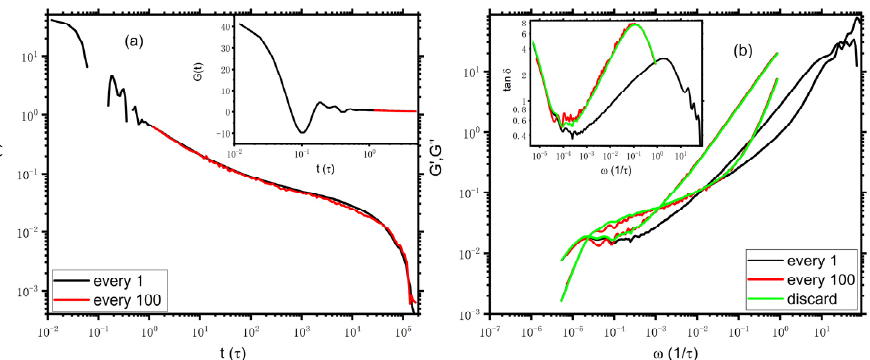
Figure 3. Stress relaxation ( a ) and viscoelastic moduli ( b ) of 𝑁 = 129 . The absolute values of 𝐺(𝑡) are input into i-Rheo GT, and the value of 𝐺(0) is 43.7. The inset in panel ( b ) presents the loss tangent tan𝛿 vs. frequency. The legends of “every 1” and “every 100” indicate the stress is calculated using every first and hundredth point, respectively. The legend of “discard” means the stress is calculated at every timestep while the data at early time (𝑡 < 1.2𝜏) is artificially discarded.